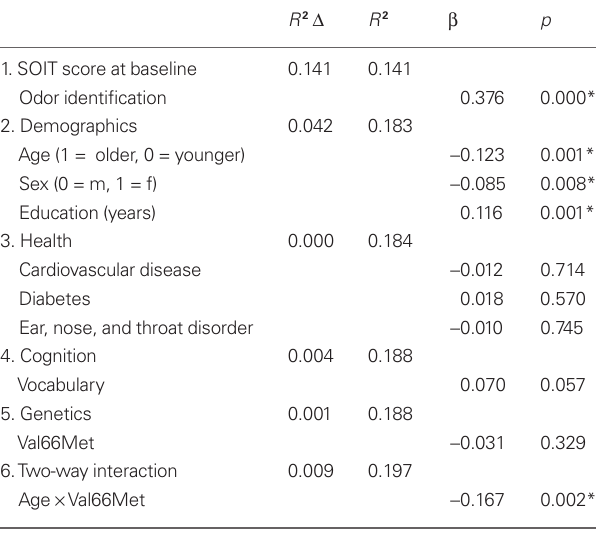
Table 3 | Hierarchical regression analysis for predicting